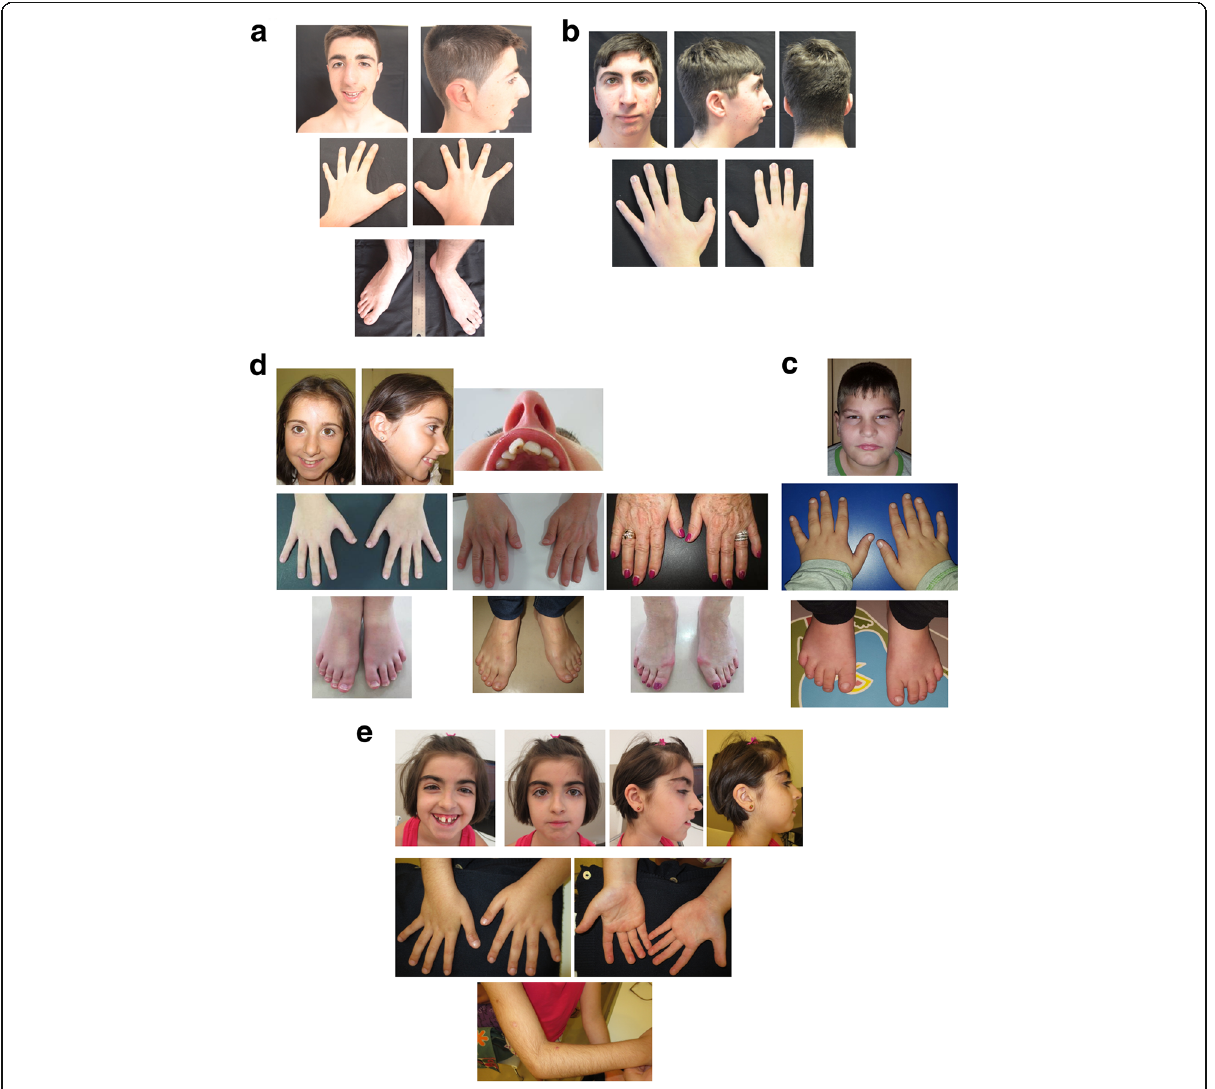
Fig. 1 Photographs of face, hands and feet of EP300 patients: #11 ( a ), #27 ( b ), #42 ( c ), #45 ( d ), #67 ( e ). For patient #45 photographs showing normal thumbs and halluces of the proband, short and broad but not angulated thumbs of her mother and her grandmother as well as detail of mother ’ s talon cusp at an upper incisor are